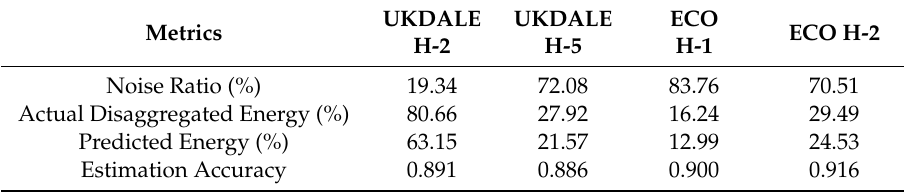
Figure 9. Energy contributions by individual appliances from ( a ) UKDALE House-2, ( b ) UKDALE House-5, ( c ) ECO House-1 and 2. Table 5. Details of energy contributions by target appliances in UKDALE and ECO datasets.